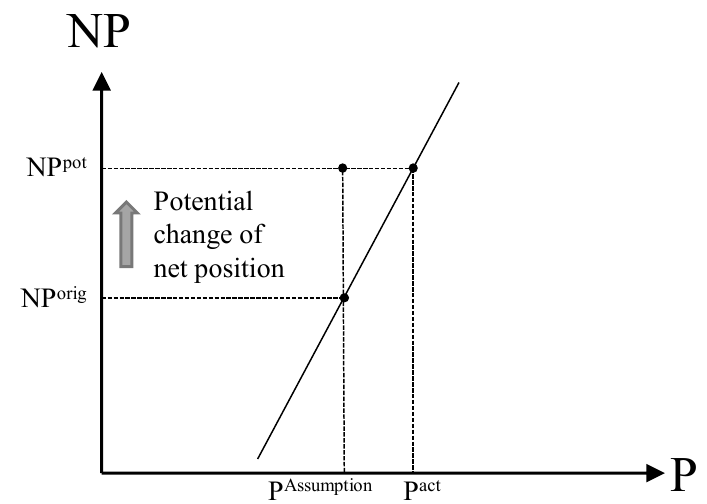
Figure 5. Relation between the change of net position and